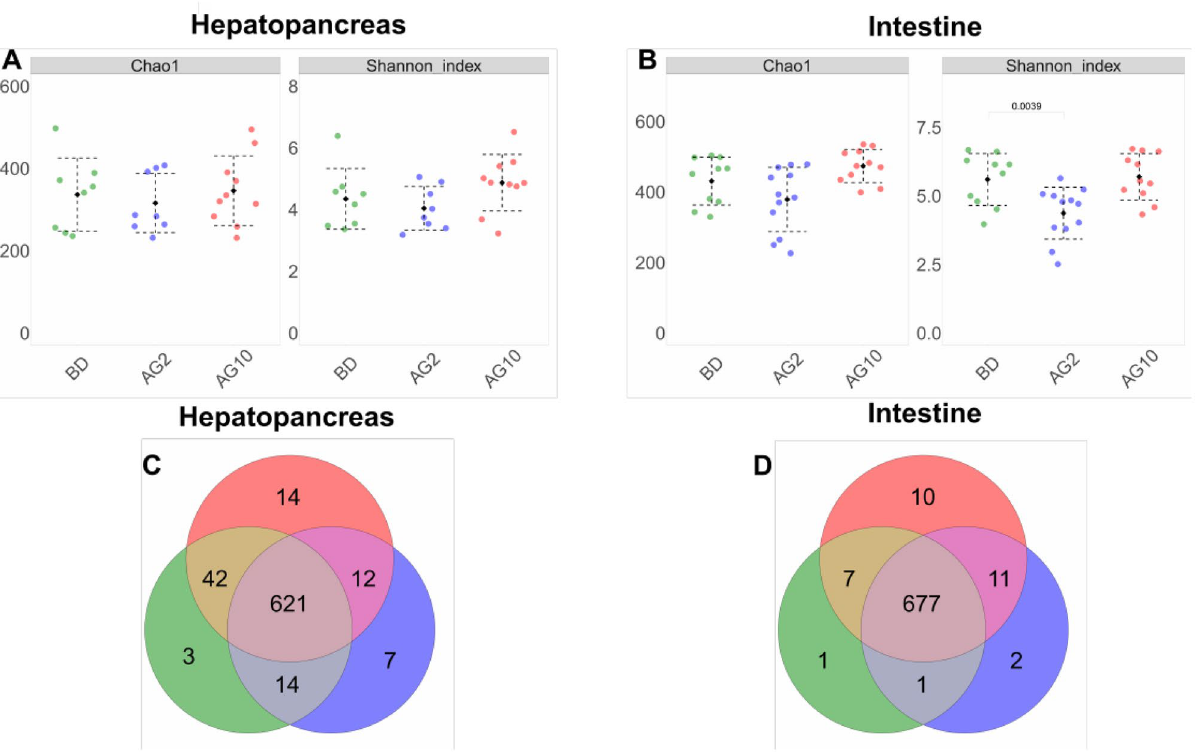
Figure 2. The alpha-diversity analysis and shared OTUs by microbiota. ( A ) Chao1 and Shannon index for the hepatopancreas ( A ) and intestine ( B ) of each treatment. Plots show the mean and standard deviation by each group. ( C ) Venn diagram shows shared and unique OTUs in the hepatopancreas. ( D ) Venn diagram shows shared and unique OTUs in the